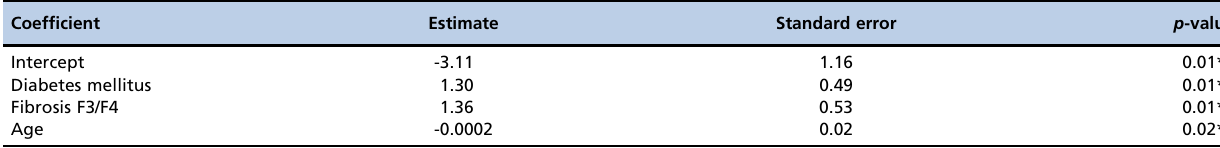
Table 3 - Results of multiple logistic regression model with HEV positivity as response variable and diabetes mellitus, age, and grade of liver fibrosis (F0/F1/F2 or F3/F4) as explanatory variables.